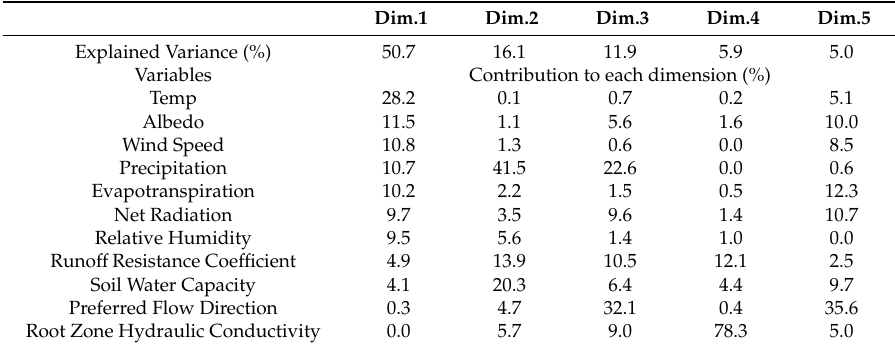
Table 1. Summary from the principal component analysis (PCA) results for the first five dimensions or eigenvectors. The upper part shows the total variance explained by each dimension and the lower, the contribution of each variable to that dimension.